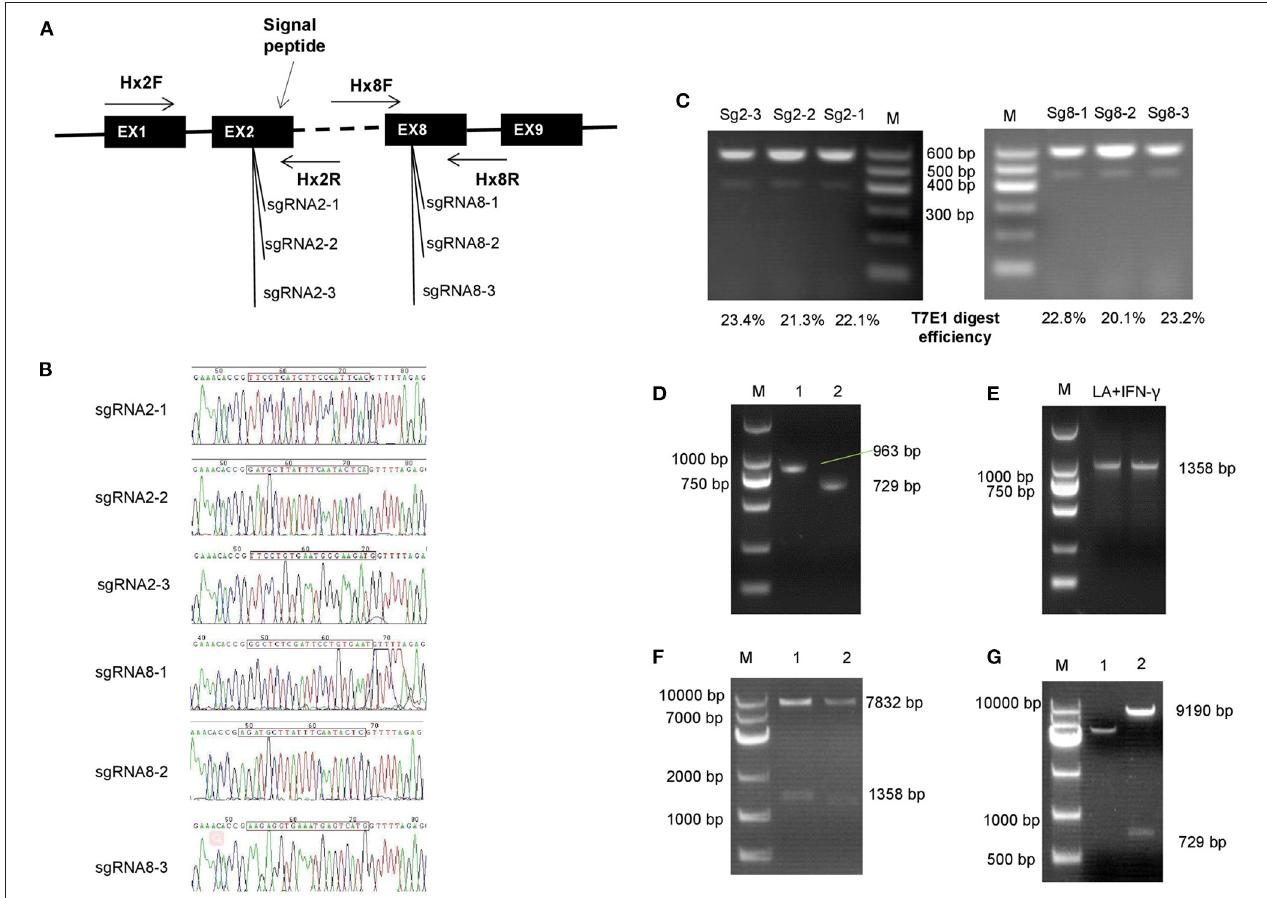
FIGURE 2 | Construction of gene-targeted and homologous integration vectors. (A) Location of single guide RNAs (sgRNAs) that were used in this study. (B) Sequencing of the target vector; the sgRNAs were inserted into the Lenti-CRISPR V2 vector followed by sequencing. (C) Digestion efficiency analysis of sgRNAs. (D–G) Homologous recombination vector construction process. (D) The homologous arm was amplified and assessed by polymerase chain reaction (PCR) assay. The bands in line 1 and lane 2 independently represent the long and the short arm length. (E) Interferon-gamma (IFN- γ ) was synthesized and inserted downstream of the long arm by overlap PCR, which was about 1,358 bp in length. (F) Long arm inserting assay, the vector was double digested by Spe I and EcoR I enzymes. Two bands in lane 1 and 2 showed that the long arm with IFN- γ was completely inserted into the homologous vector. (G) Enzyme identification of the entire combination vector. The short arm was digested from the recombination vector by Kpn